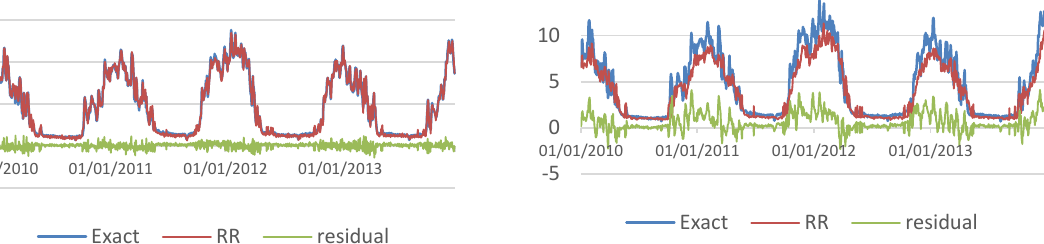
Figure 3. Exact values and RR approximation of natural gas consumption for one-day ahead prediction based on test data